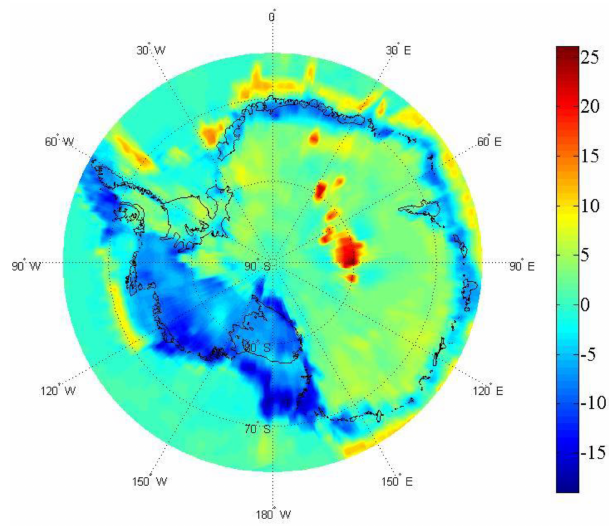
Figure 3. Difference between crustal models AN1 and CRUST 1.0 based on seismological data. Units are kilometers